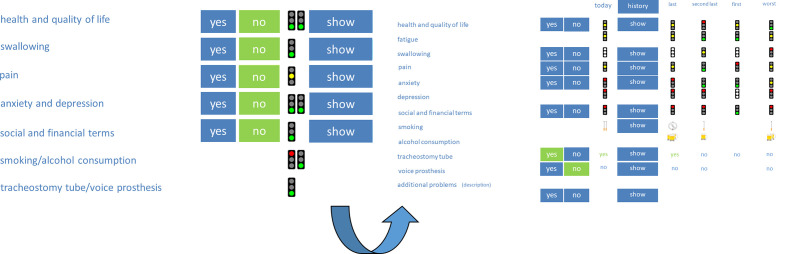
Visualization of the original questionnaire and examinations with traffic lights. Red color symbolizes a lousy condition, yellow color, a moderate condition, and green color, a good condition of the patient.